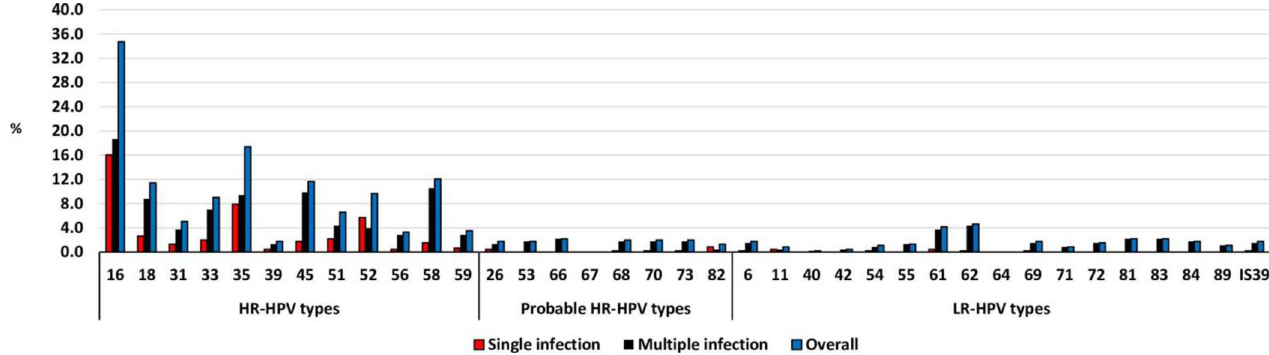
Fig 2. Human papillomavirus genotype distribution among women referred to Nelson Mandela Academic Hospital Gynaecology department, Eastern Cape Province. Single HPV infection is defined as infection with one HPV type, while multiple HPV infections as the detection of two or more HPV types in the same